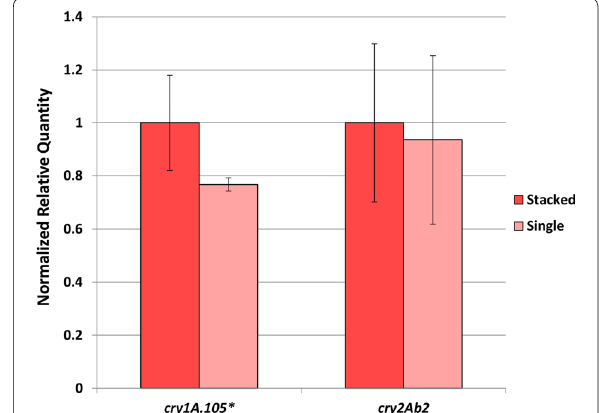
Fig. 3 Transgene transcripts normalized relative expression levels measured by delta‑delta Cq method and Pffafl correction equation. The cry1A.105 and cry2Ab2 transgenes were quantified in single versus stacked transgenic maize events grown under controlled conditions at V3 stage. Samples are means of three pools, each derived from ten different plants. ‘Bt’ samples are from MON‑89Ø34‑3 event, and ‘RR Bt’ samples are transgenic maize seedlings from × MON‑89Ø34‑3 MON‑ØØ6Ø3‑6 event. Bars indicate standard × deviation and statistically significant values ( p < 0.05) are represented by